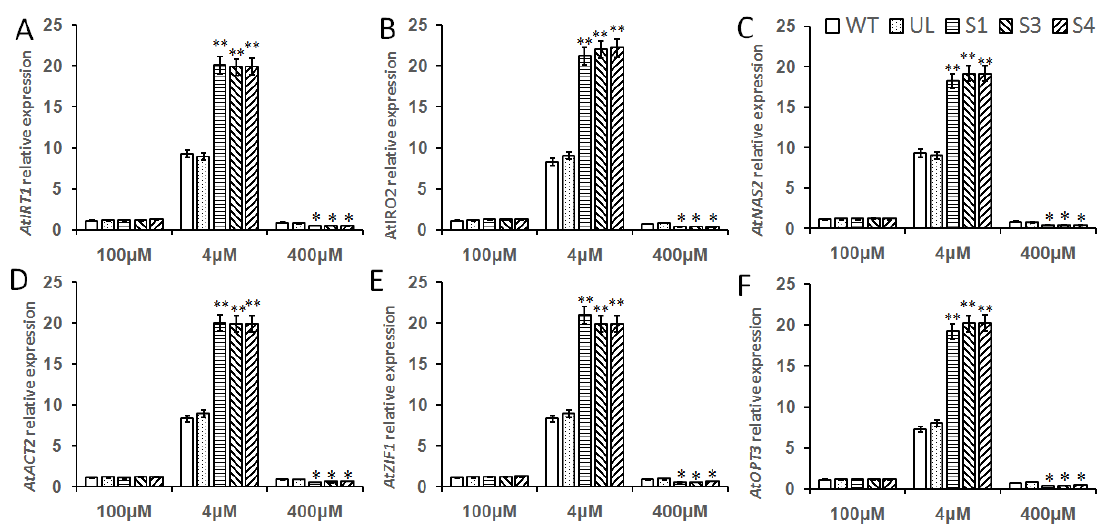
Figure 9. Relative expression levels of iron stress related genes in WT, UL and transgenic Arabidopsis . The relative expression levels of AtIRT1 ( A ), AtFRO2 ( B ), AtNAS2 ( C ), AtACT2 ( D ), AtZIF1 ( E ) and AtOPT3 ( F ). Data represent means and standard errors of three replicates. Asterisks above columns indicate significant difference compared to that in WT (* p ≤ 0.05, ** p ≤ 0.01).